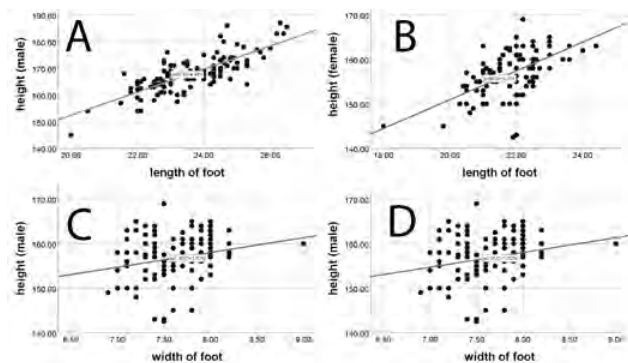
Fig 2: Scatter plots showing linear relationship between stature and foot dimensions